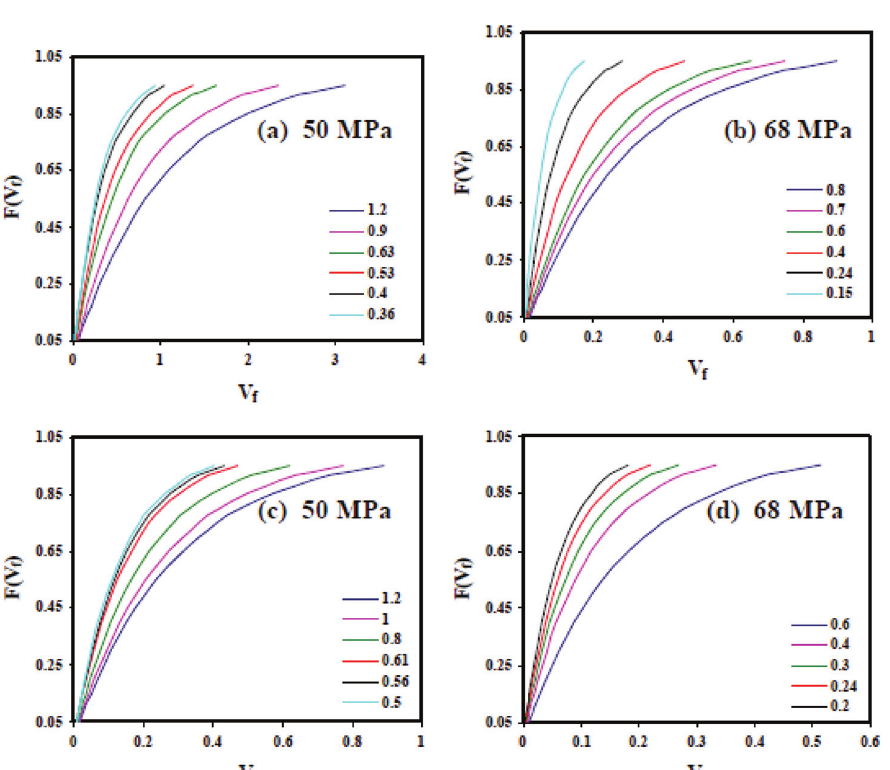
Figure 9: Probability distribution of void area fraction at 870°C/56 MPa: (a) top and (b) bottom portion of service exposed refor- mer tube, at various true